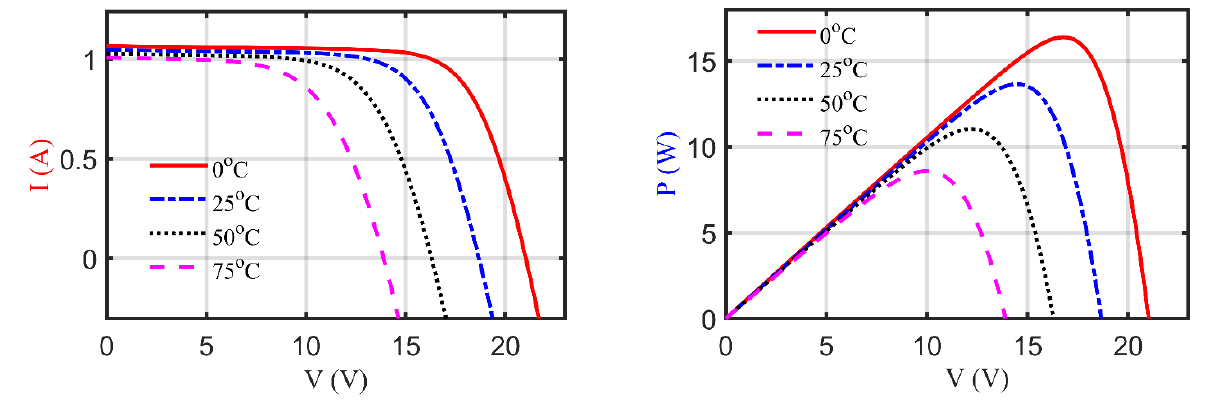
Figure 7. Principal characteristics of PWP201 unit.